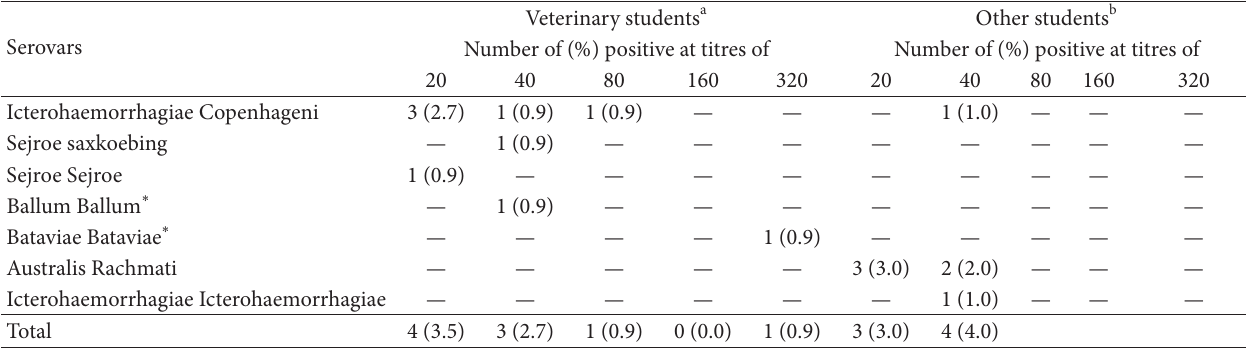
Total A sample had multiple agglutination. a Based on a total of 113 students. ∗ b Based on a total of 99 samples from 46 dental, 39 nursing, and 14 pharmacy students. —: